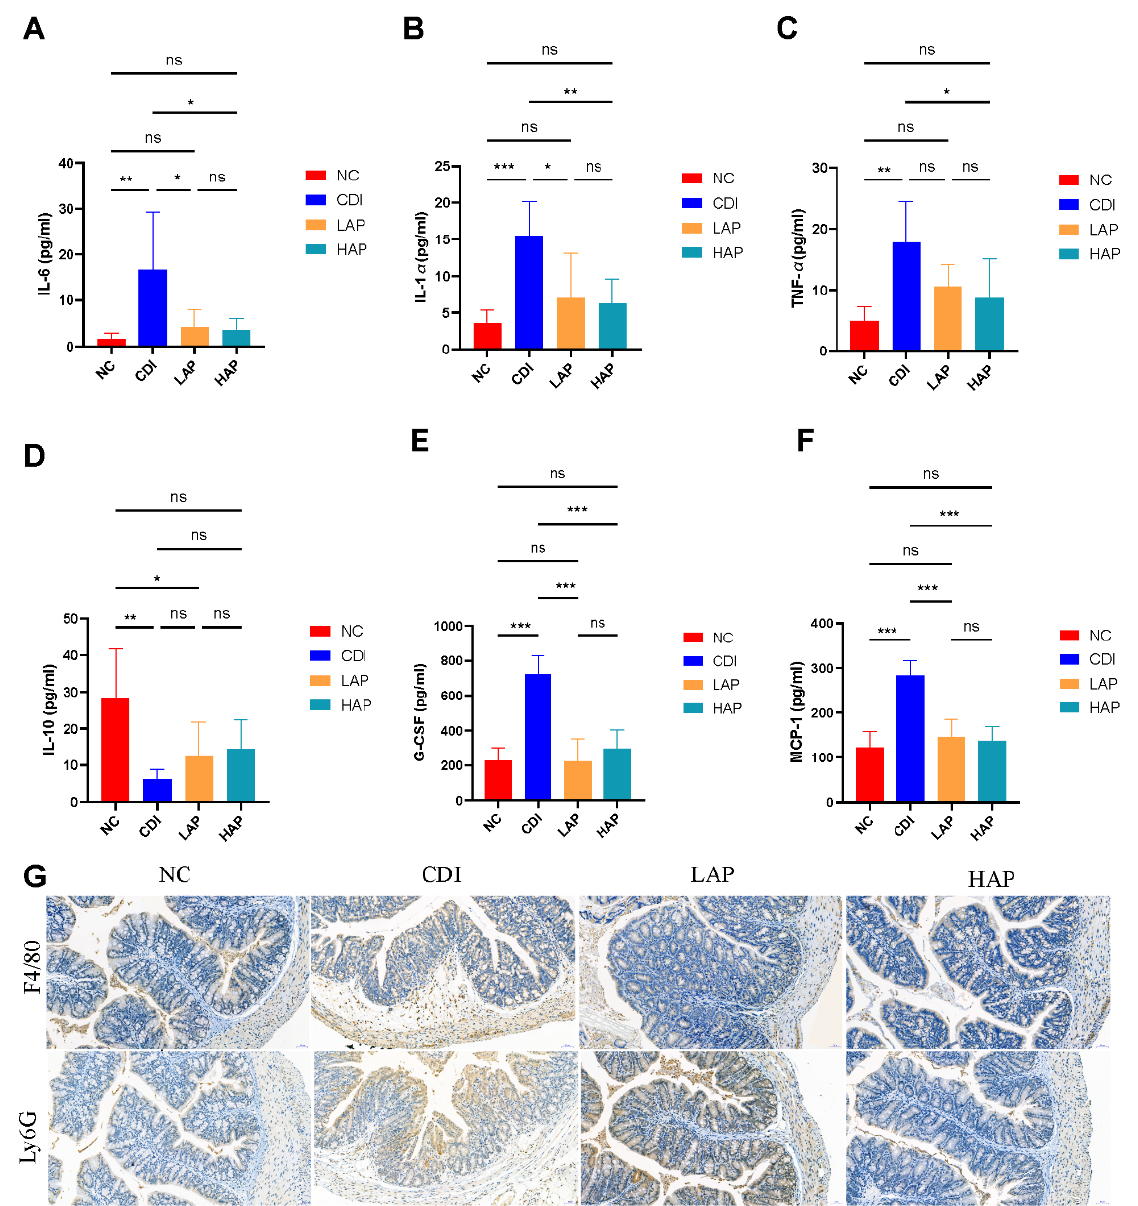
Figure 4. APE attenuated C. difficile -induced inflammatory. ( A – F ) Expression of cytokines (IL-6, IL-1 α , TNF- α , IL-10, G-CSF, and MCP-1) in serum. ( G ) Immunohistochemical staining of colonic tissues for F4/80 and Ly6G indices. Data are expressed as mean ± SEM. * p < 0.05, ** p < 0.01, *** p < 0.001.